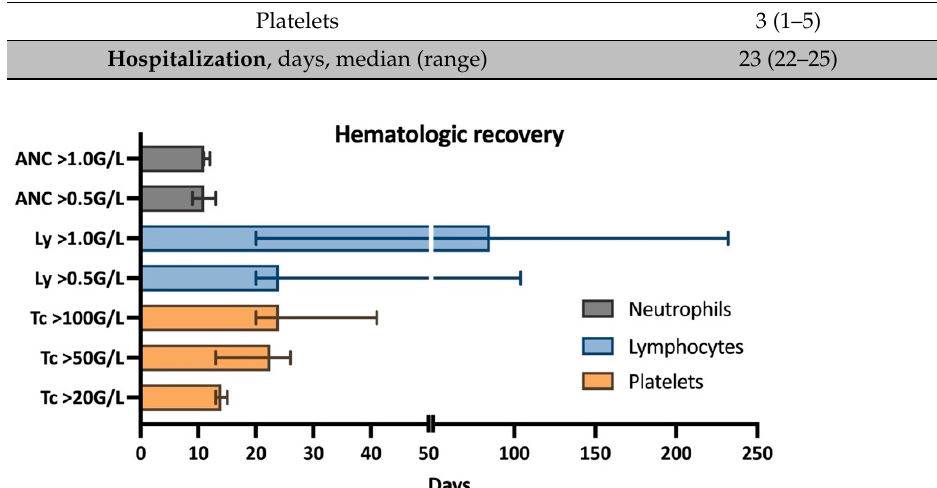
Figure 1. Hematologic recovery: ANC, absolute neutrophil count; Ly, lymphocytes; Tc, platelets.